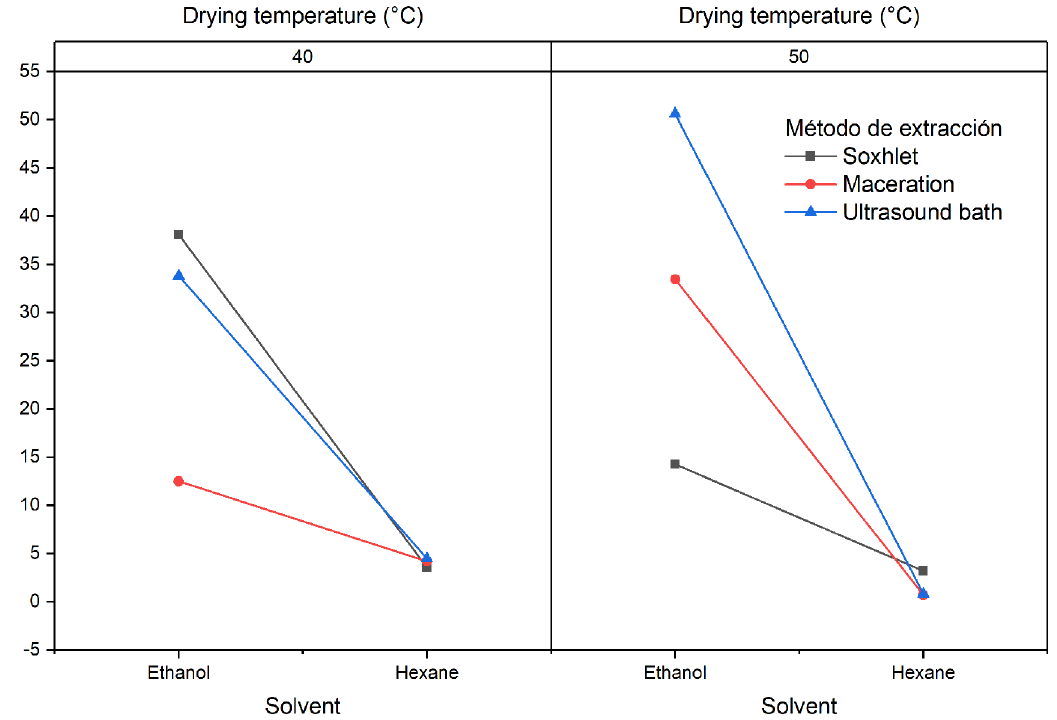
Figure 5. ANOVA graph for the influence of factors on the extraction yield of Croton